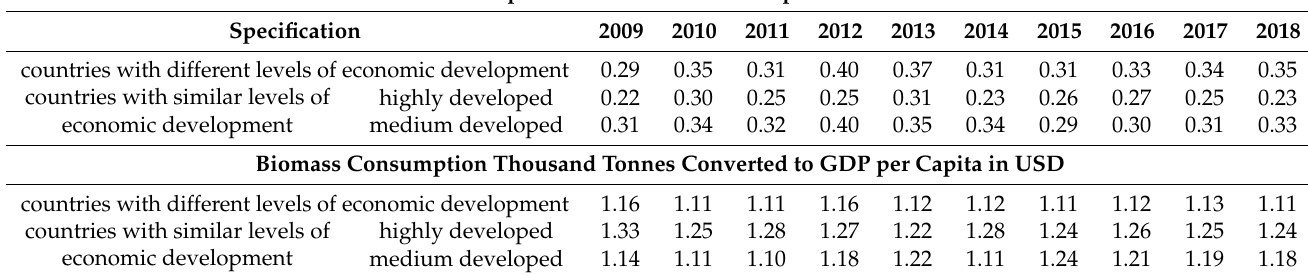
Table 11. Sigma coefficients ( σ )-convergence in the studied EU countries with different and similar levels of economic development in relation to biomass consumption—in thousand tonnes per 1000 inhabitants and in thousand tonnes, converted to GDP per capita in